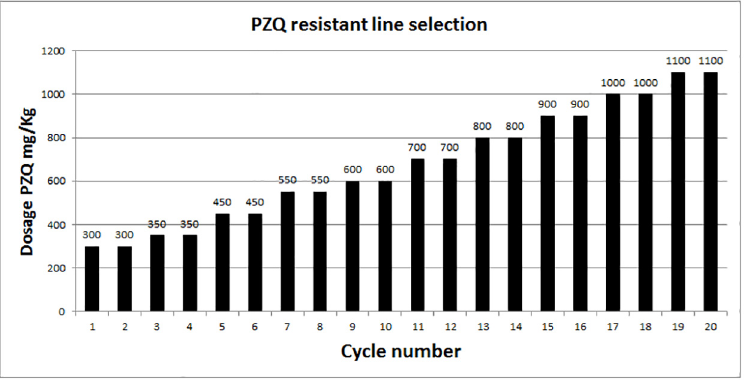
Fig 2. Schematic cartoon of PZQ dosages during the selection procedure for the S . mansoni PZQ- resistant strain. The parasite from BH susceptible strain was submitted to various steps of PZQ pressure, and the dosage was increased along the cycle number of